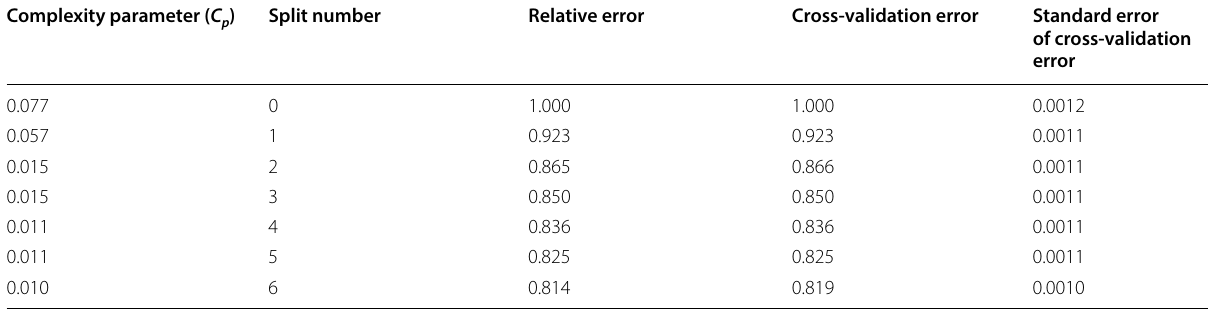
Table 1 Splitting criteria with validation statistics in the fitted regression tree of temperature of veneers Complexity parameter ( C p )